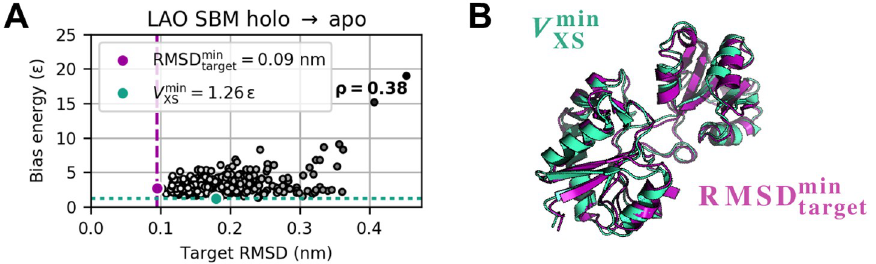
Fig 8. Bias potential versus target RMSD for LAO protein’s holo-to-apo transition. (A) Bias potential versus target (purple) and V min (turquoise) structure feature a C α RMSD of 0.16 nm with respect to each RMSD. (B) RMSD min target XS